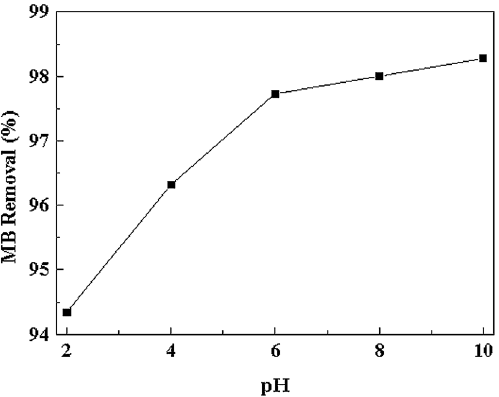
Figure 6. Effect of p H . Conditions: MB concentration: 50 mg/L; Volume = 25 mL, Absorbent dose = 30 mg; Temp. = 30 ± 10 °C; Speed of agitation = 200 rpm; Contact time = 60